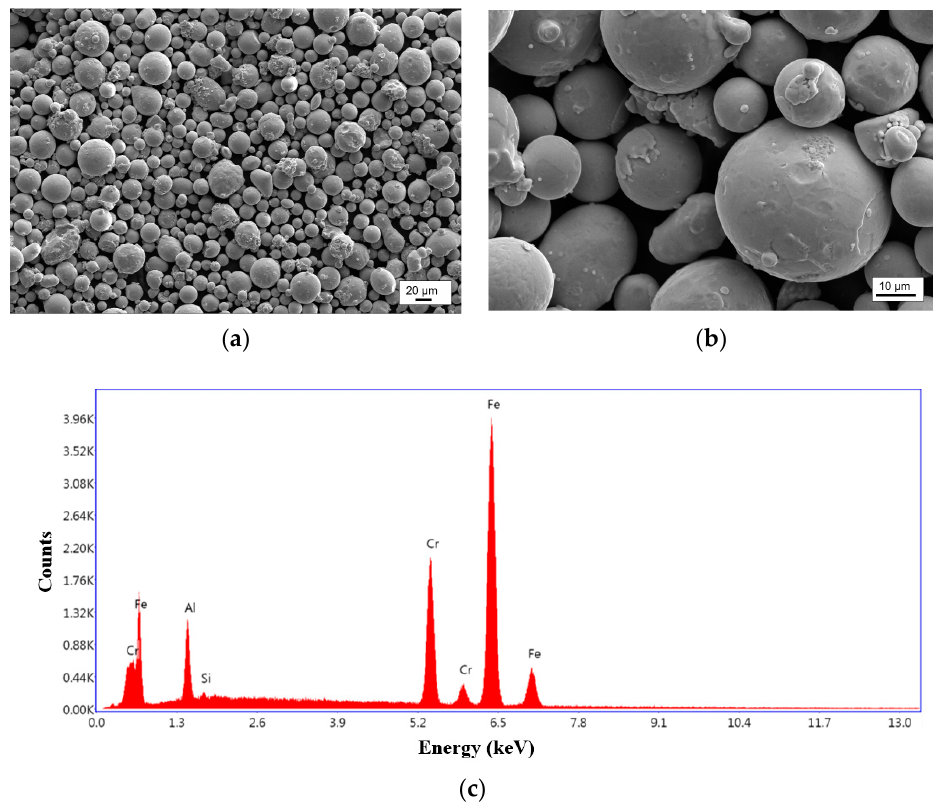
Figure 1. Fe20Cr5.5AlY powder used for LDED-PF ( a ) morphology at low magnification, and ( b ) morphology at higher magnification; ( c ) element spectrum .